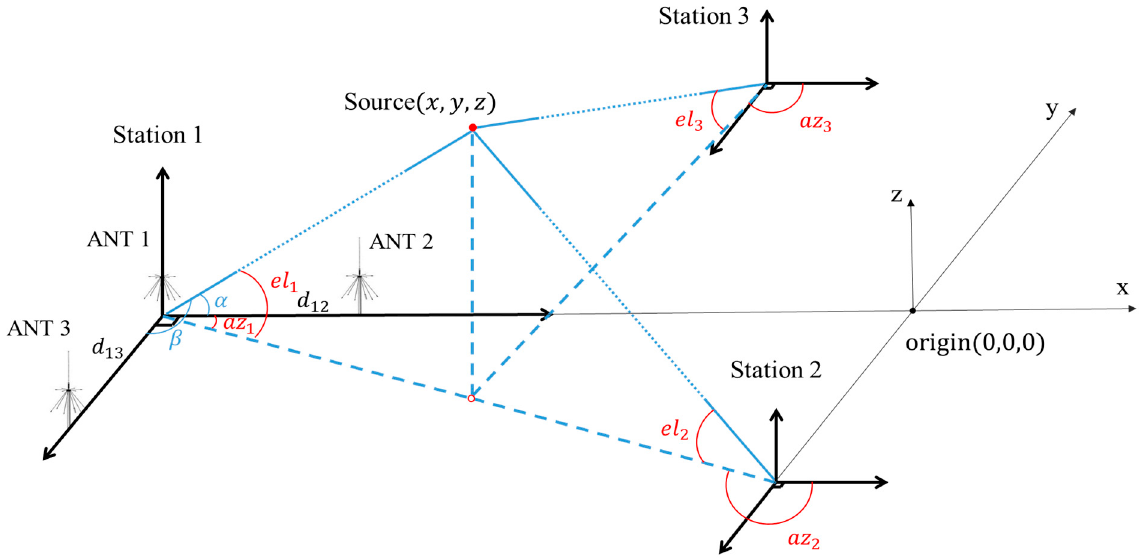
Figure 3. Illustration of three station InLMA with an assumed point discharge source ( x , y , z ) which radiates electromagnetic waves to the three stations. The corresponding angles are denoted and used to find the 3D location of the source ( x , y , z )